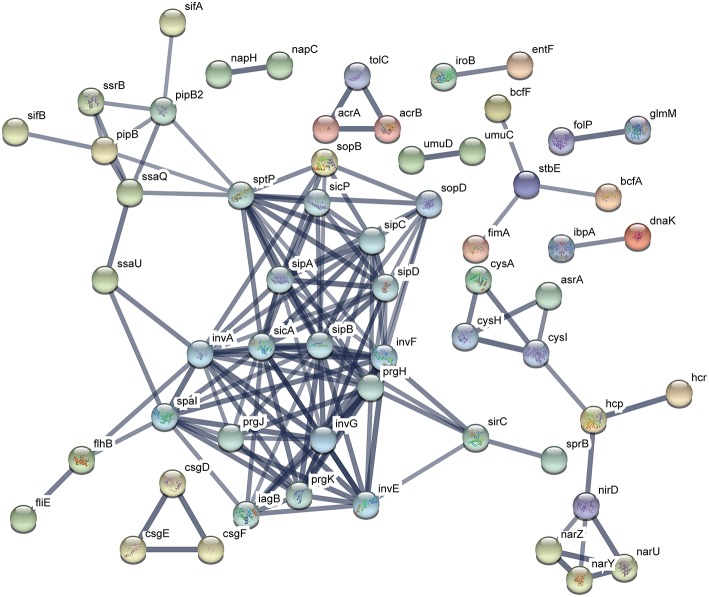
Functional protein association networks of chromosomal DEGs after acquiring pHXY0908. Each node is a protein. Each edge represents protein-protein associations. The thicker edges indicate higher levels of confidence.